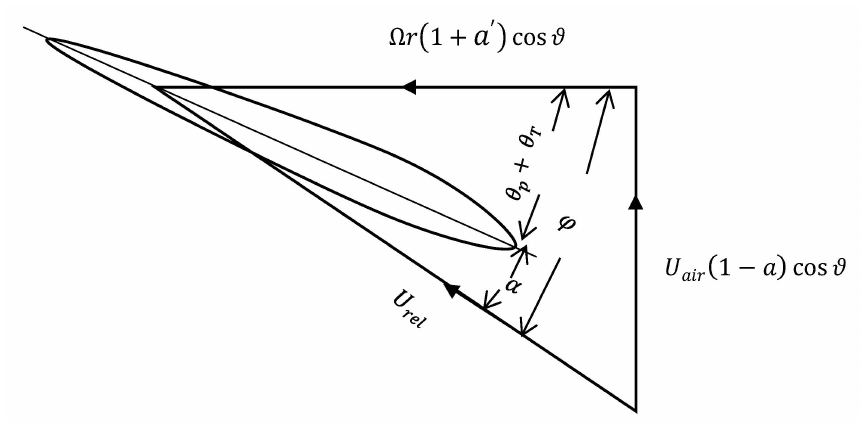
Figure 2. Blade element